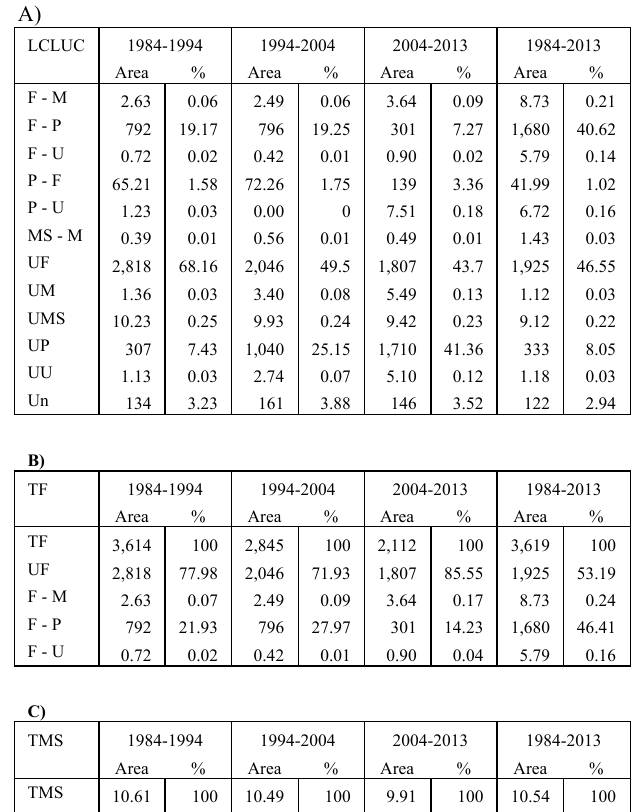
Figure 4. Qunatification of land cover and land use changes between 1984-1994, 1994-2004, 2004-2013 and 1984-2013, from “from-to” object detection approach.